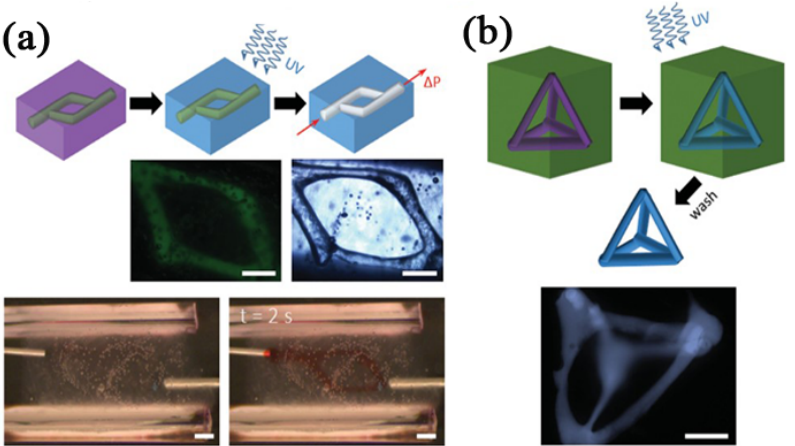
Figure 8. ( a ) 3D bioprinting a branched channel. After the 3D printed ‘bioink’ was UV crosslinked, a flow driven by pressure caused the supporting suspension to be removed, leaving the